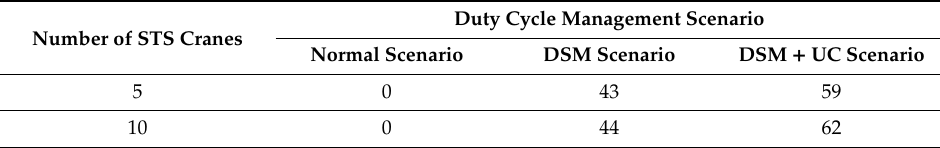
Table 7. Percentage of the peak shaving (% PˆS ) for the STS crane group in di ff erent scenarios. Number of STS Cranes